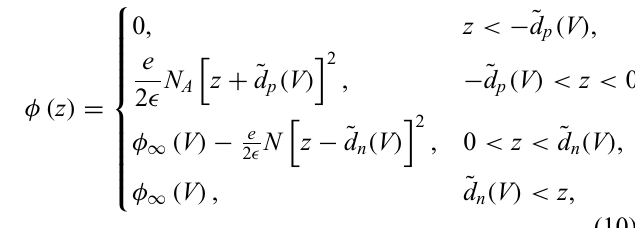
[Fig. 2(a)]. The semiconductor’s band gap, E where (cid:6) and (cid:6) v correspond to the energy of the conduction c and valence bands, respectively [Fig.